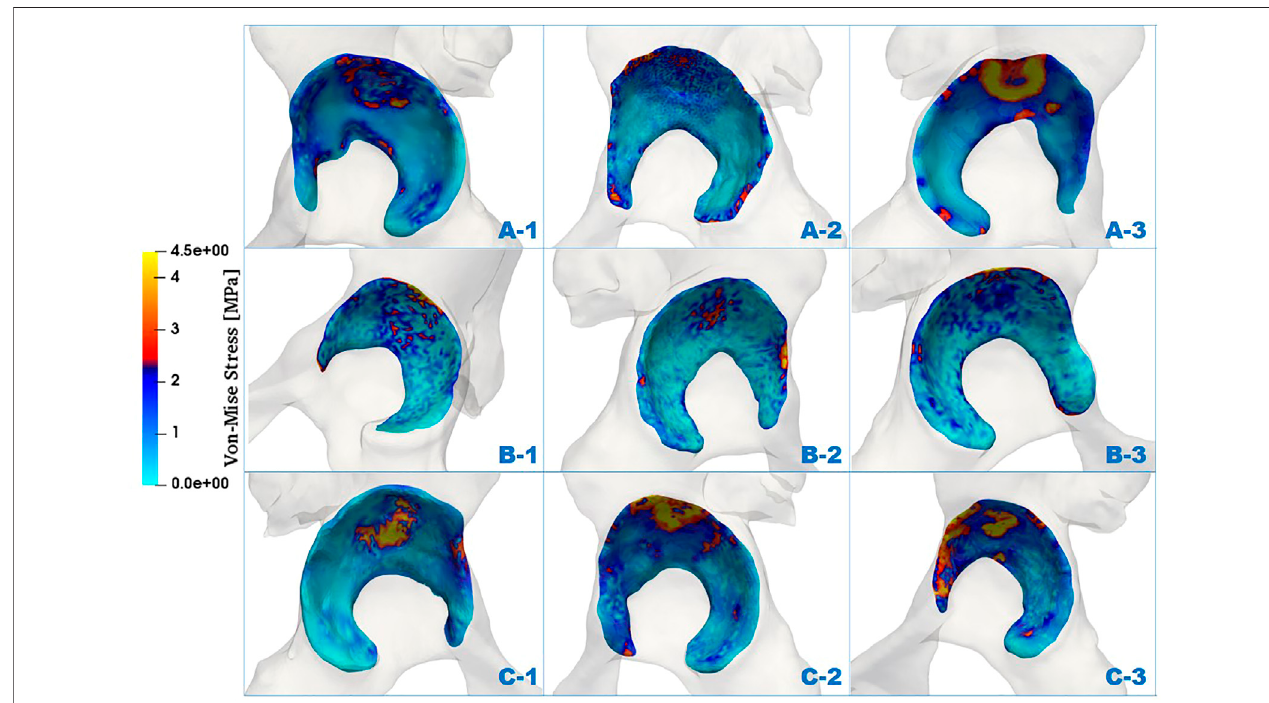
FIGURE 6 | The area ratio in each von Mises stress interval for results on facies lunata is displayed, and a circle icon represents the average percent value for each stress interval.